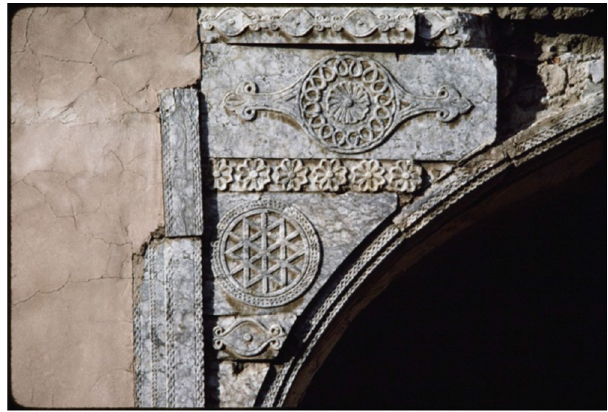
Fig. 7. Mosulian Marble used in decorating arches in one the houses in Mosul [Mosul eye].